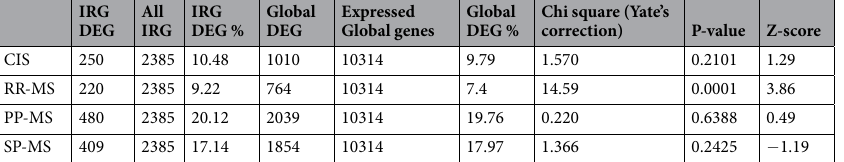
Table 2. Probability of IRG DEG enrichment at distinct stages of multiple sclerosis. HC = Healthy controls; CIS = clinically isolated syndrome; RR-MS = Relapsing-Remitting multiple sclerosis; PP-MS = Primary progressive multiple sclerosis; SP-MS = Secondary progressive multiple sclerosis; DEG = differentially expressed